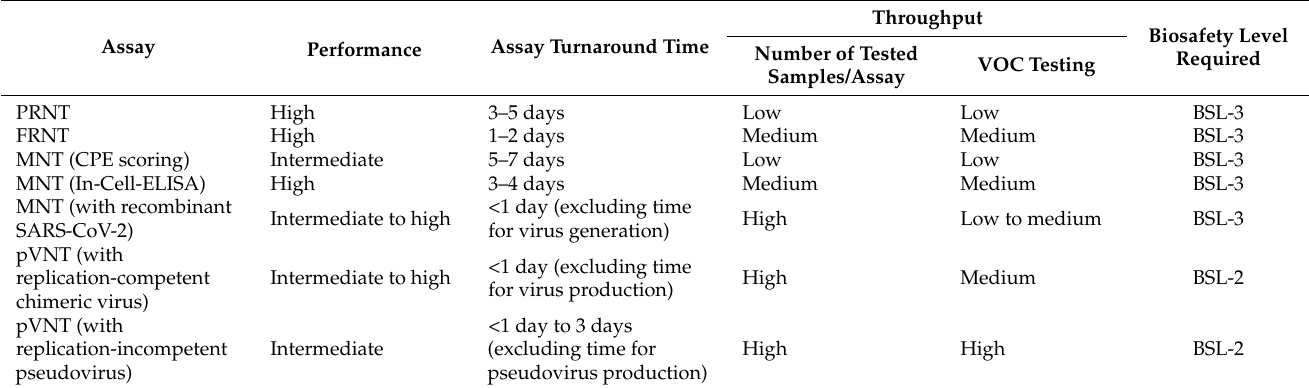
Table 1. Characteristics of cell-culture-based assays to detect SARS-CoV-2